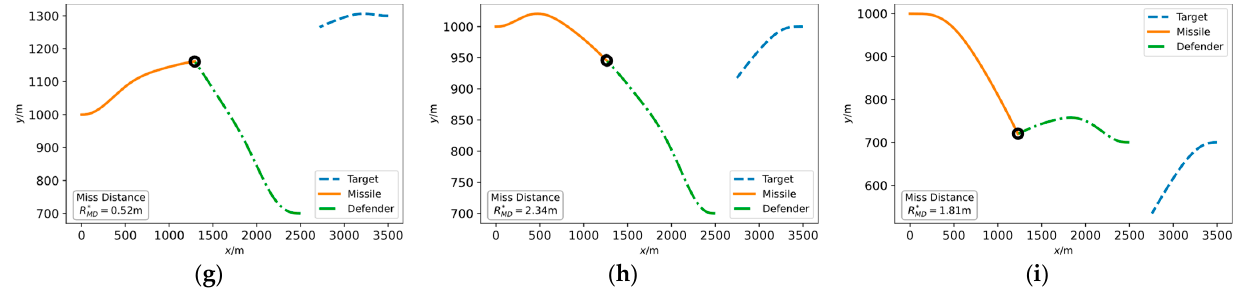
Figure 7. Engagement trajectories of assessing target/defender agent under different simulation conditions, i.e., different target longitudinal position y T and defender longitudinal position y D :